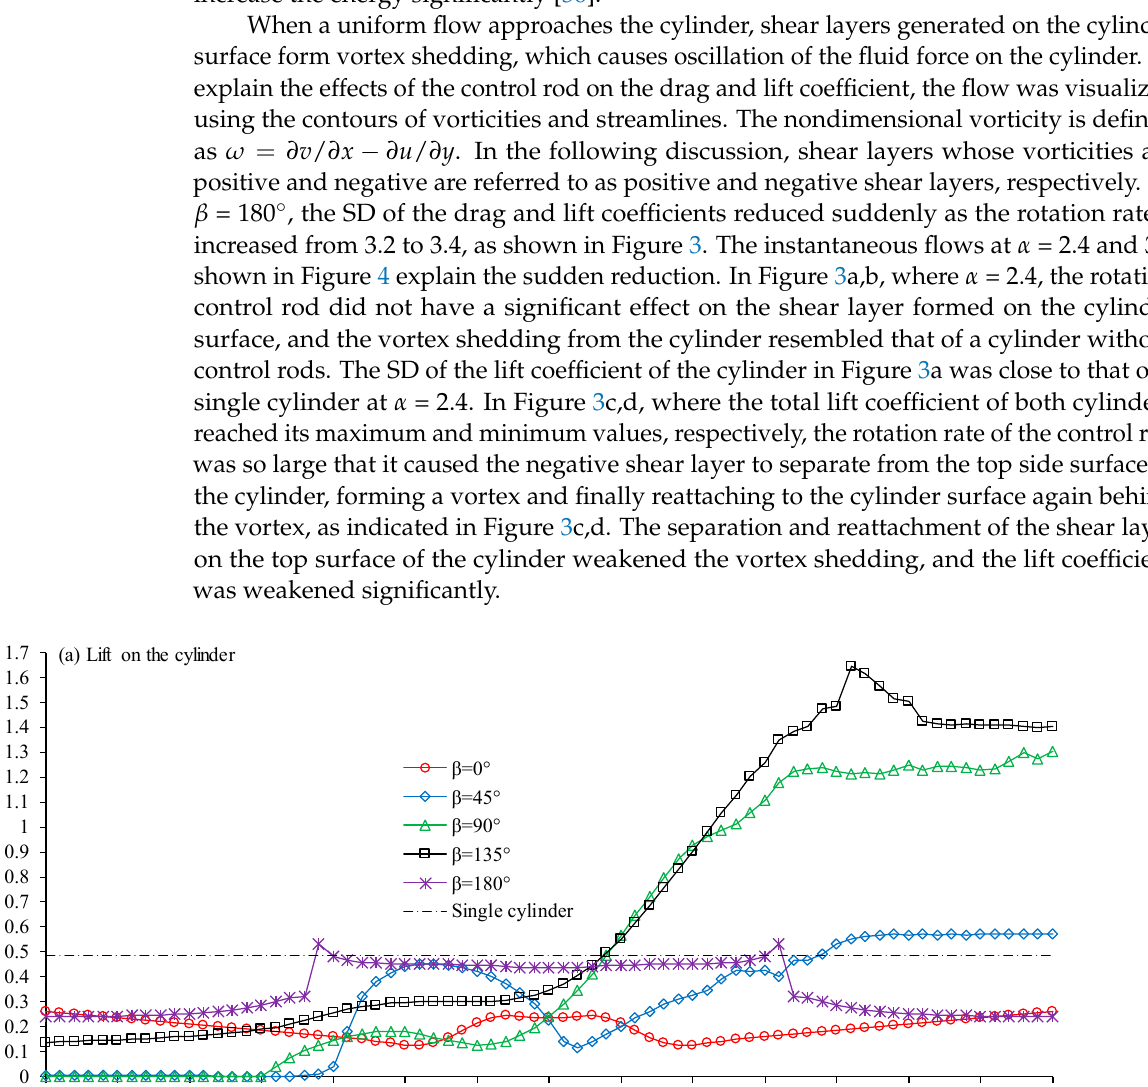
Table 2. Statistical values of the drag and lift coefficients in the time-step dependency study for β = 90° and α =